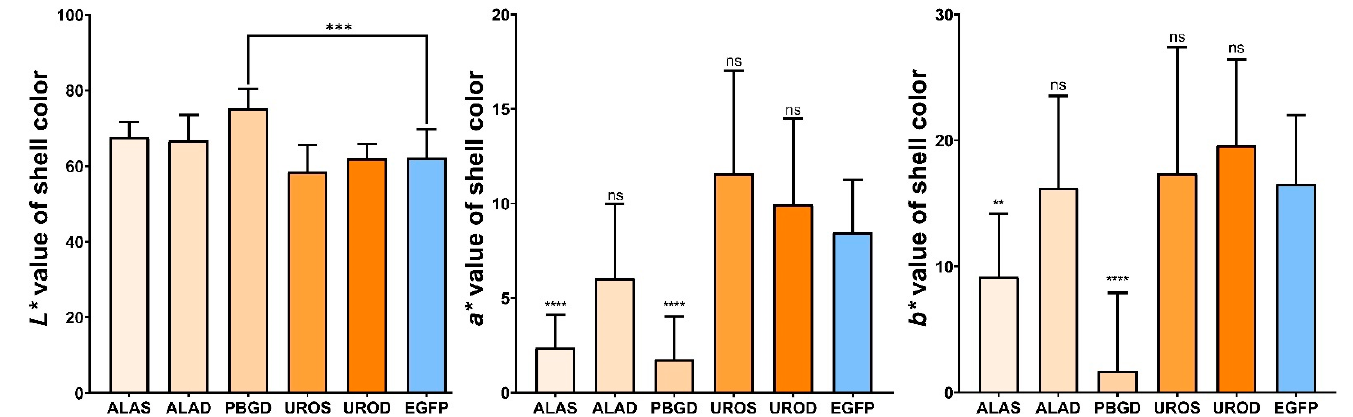
Figure 3. The analysis of L*a*b* value of the newly deposited shell. Comparison of L*a*b* value of newly deposited shell between groups CgALAS , CgALAD , CgPBGD , CgUROS , CgUROD and the EGFP group. The p values from a t -test demonstrate ** p < 0.01, *** p < 0.0005 or **** p < 0.0001; and ns demonstrates no significance.